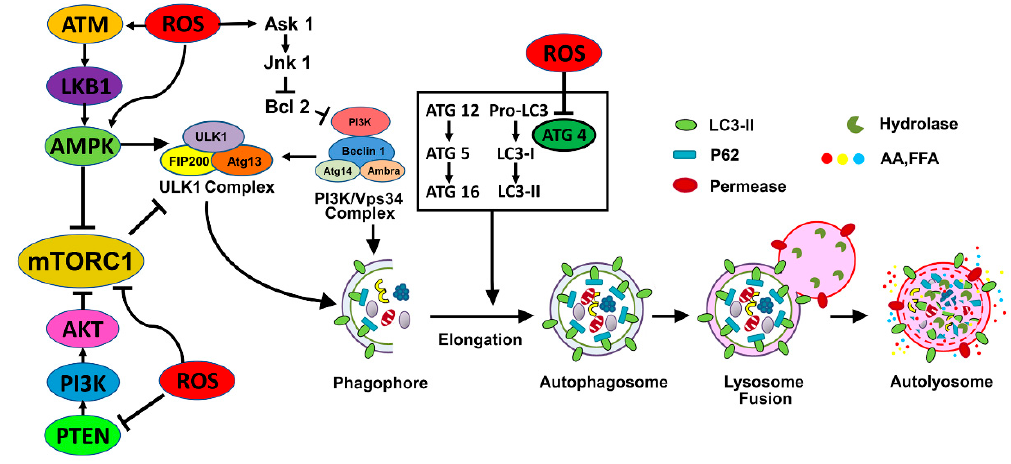
Figure 2. Regulation of autophagy by ROS. ( Top left ) Under conditions of oxidative stress, ROS oxidize cysteines located in the α and β subunits of AMPK, by activating AMPK and its downstream signaling. Members of the Bcl-2 family suppress autophagy by binding beclin-1 and preventing beclin-1 from forming the PI3 kinase / Vps34 complex of the autophagy pathway. ROS-mediated oxidation of Ask1 results in dissociation of the Bcl-2–beclin-1 interaction, making free beclin-1 available for the formation of PI3 kinase / Vps34 complex and subsequent autophagy activation. ( Top right ) H 2 O 2 oxidizes the cysteine 81 residue of Atg4, which inactivates the protease to facilitate Atg8 in the formation of autophagosome. ( Bottom) Oxidative stress also oxidizes mTORC1 and PTEN, which inhibits their activity and promotes autophagy. Suppression of mTORC1 and induction of AMPK promote ULK1 complex (ULK1, Atg13, FIP200, and Atg101) activation at the pre-autophagosomal assembly site (a certain domain of the ER) and initiates the autophagy